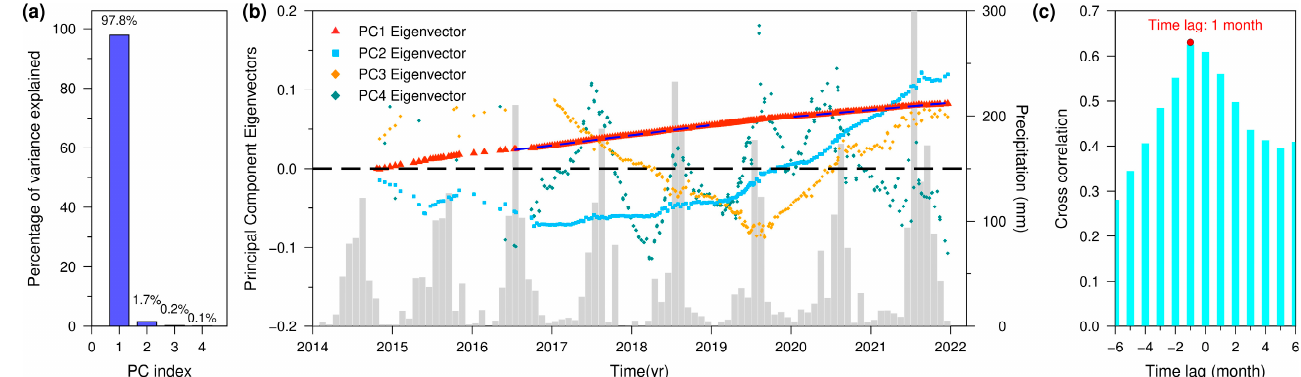
Figure 14. Results from the T-mode PCA on the InSAR-derived vertical displacement time series. ( a ) A scree plot illustrating the percentage of displacement explained by the first four PCs; ( b ) Tem- poral variations of the PC1, PC2, PC3, and PC4 eigenvectors; the gray bars show the monthly pre- cipitation in Tianjin. The blue dashed lines indicate the derived linear trend of PC1 before and after 2019; ( c ) The cross-correlation between the precipitation and the eigenvector of PC4.